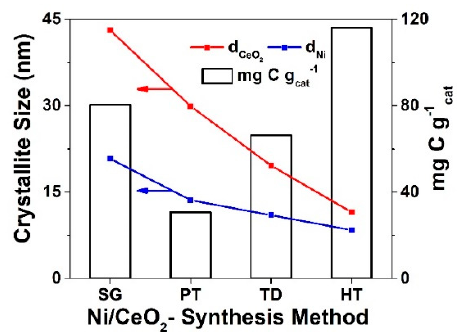
Figure 9. Comparative graph of the crystallite size (d CeO2 and d Ni , nm) and amount of carbon deposition (mg C g − 1 ) after 12 h in DRM as a function of ceria support synthesis